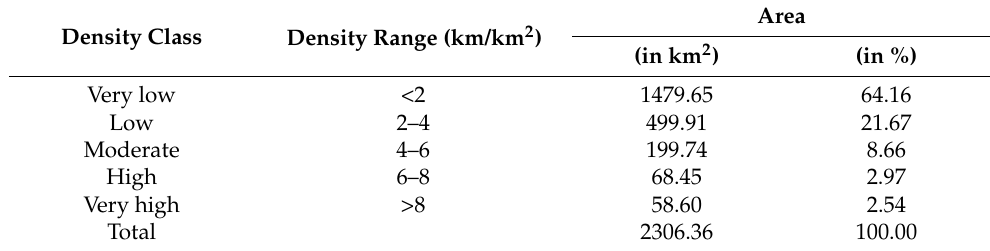
Table 4. Area of lineament density classes.